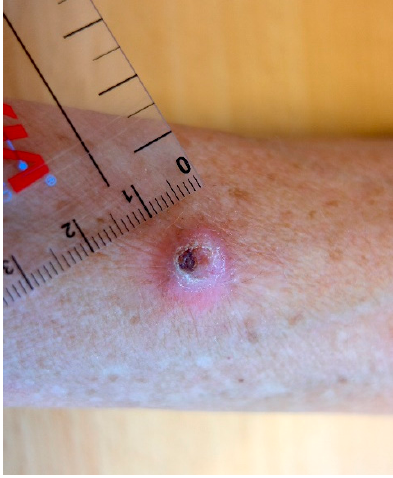
Figure 1. Macroscopy, hyperkeratotic nodule on forearm. Three weeks after the first consultation, the nodule was excised with a safety margin of about 3 mm. Surprisingly, histology revealed a collision tumor consisting of keratoacanthoma and melanoma with a Breslow thickness of 4.6 mm (Figure 2). Consequently, the patient was referred to a hospital specialized in melanoma for further diagnostics and therapy (PET-CT scan and evaluation of sentinel lymph node biopsy). Unfortunately, the